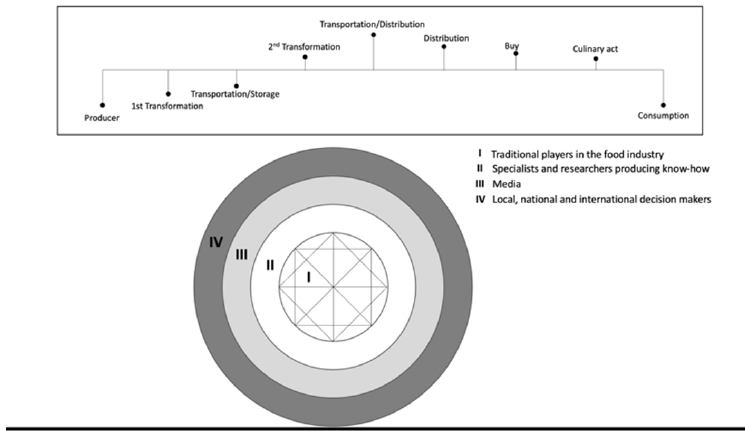
Figure 2. The diadrama of eating.